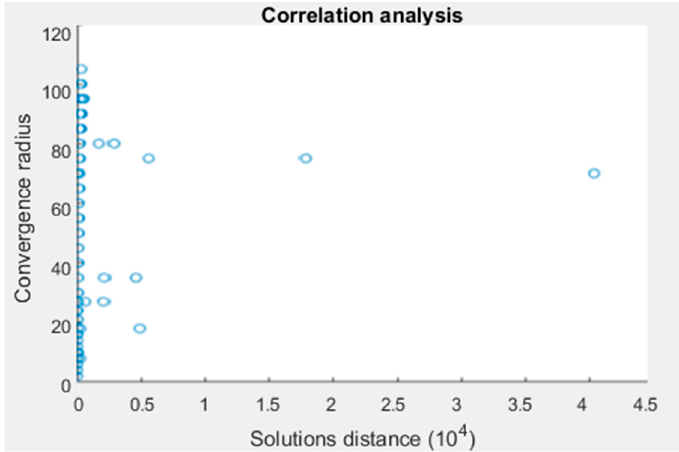
Figure 3. Outliers of the correlation between radius of convergence and distance between solutions.